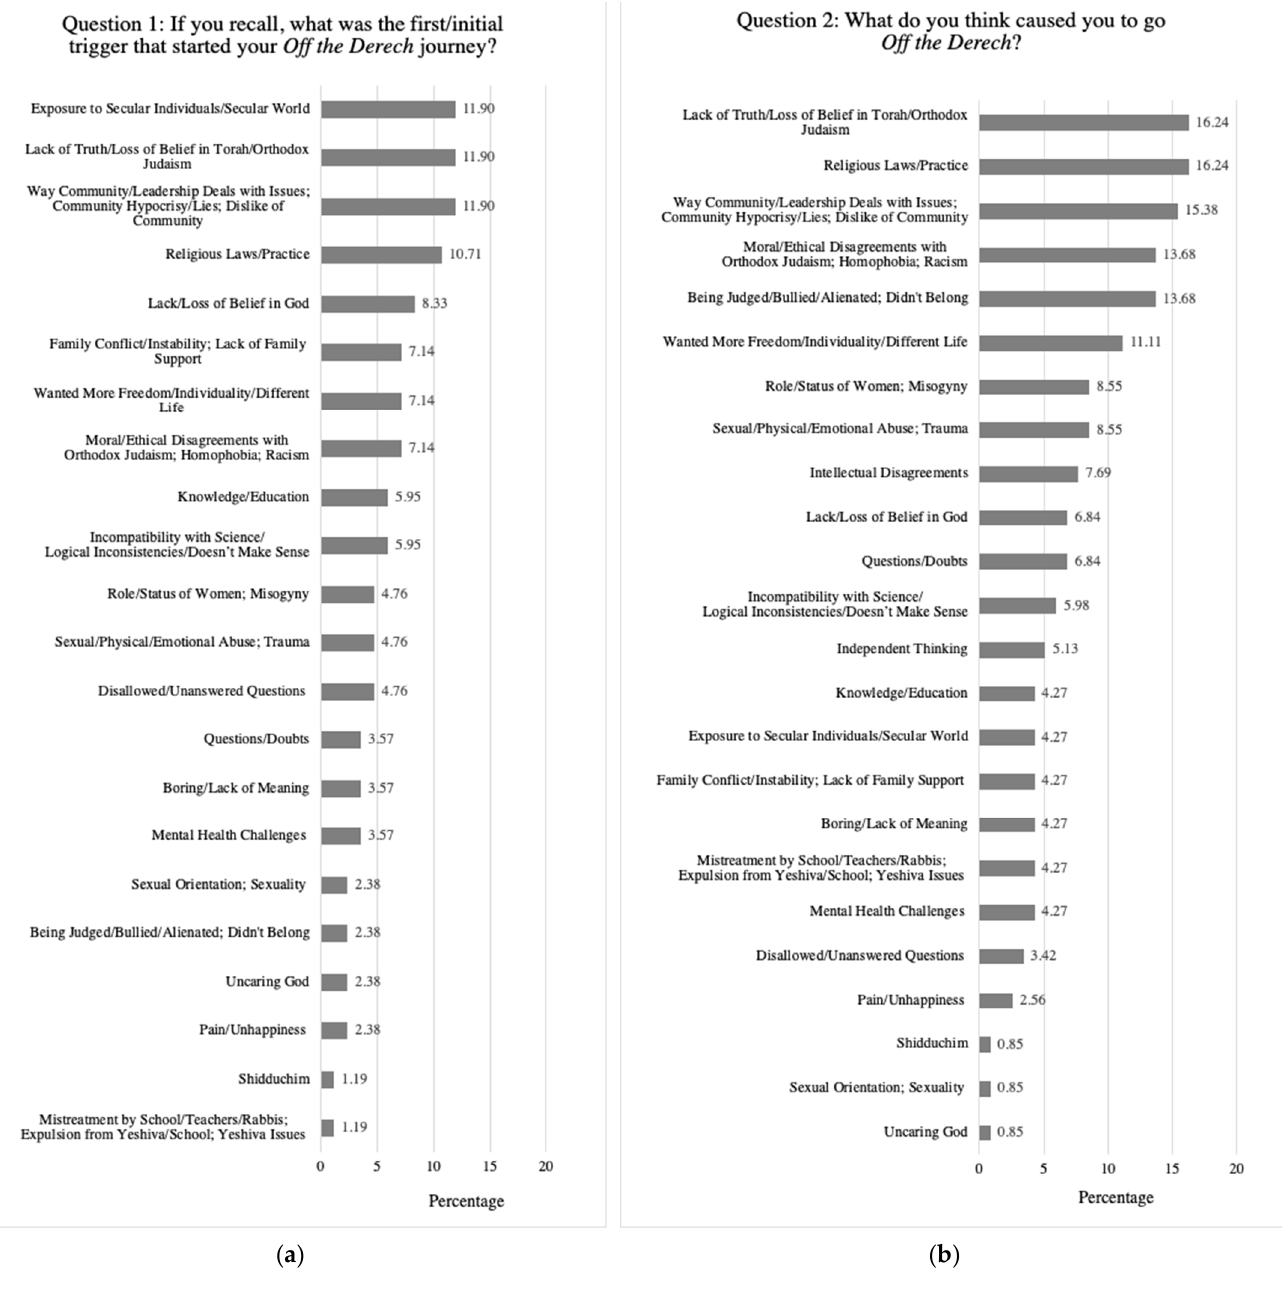
Figure 2. ( a ) Percentage of LGBTQ+ participants reporting triggers for disaffiliation for Question 1: If you recall, what was the first/initial trigger that started your Off the Derech journey? ( b ) Percentage of LGBTQ+ participants reporting causes for disaffiliation for Question 2: What do you think caused you to go Off the Derech? Participants had the option to report multiple causes in response to this question, therefore percentages add up to a sum greater than 100%.